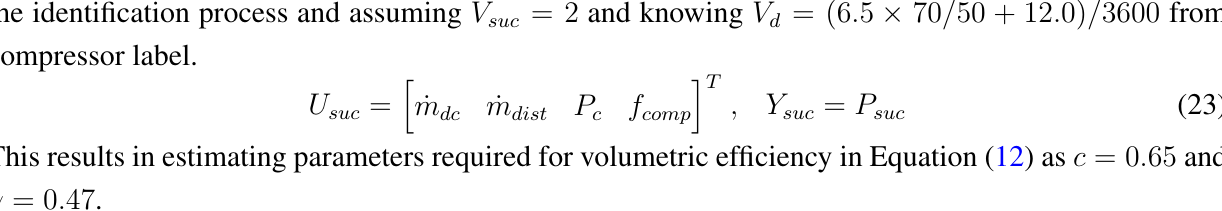
Figure 6. Suction pressure and power consumption estimations. Variation of consumption is mainly because of changing mass flow due to hysteresis and superheat control of expansion valves. Mechanical-electrical efficiency is obtained as η training data; ( b ) Estimation using validation